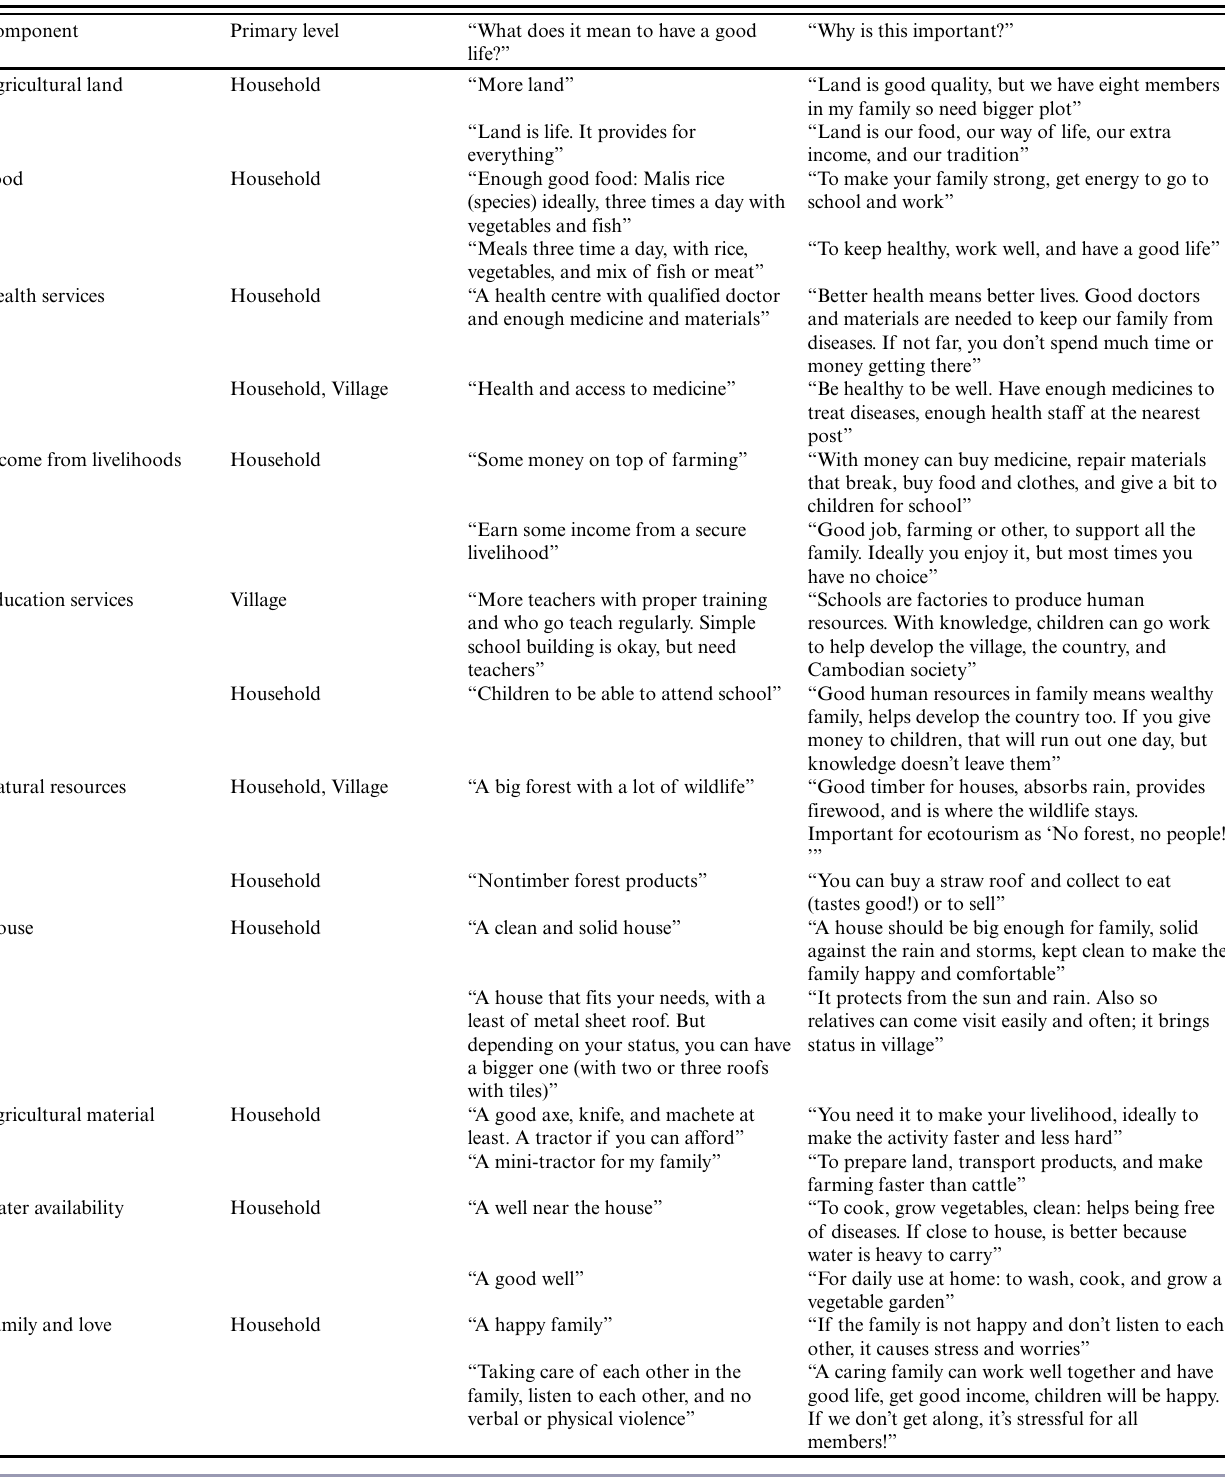
Table 3. Quotes exemplifying the categorization